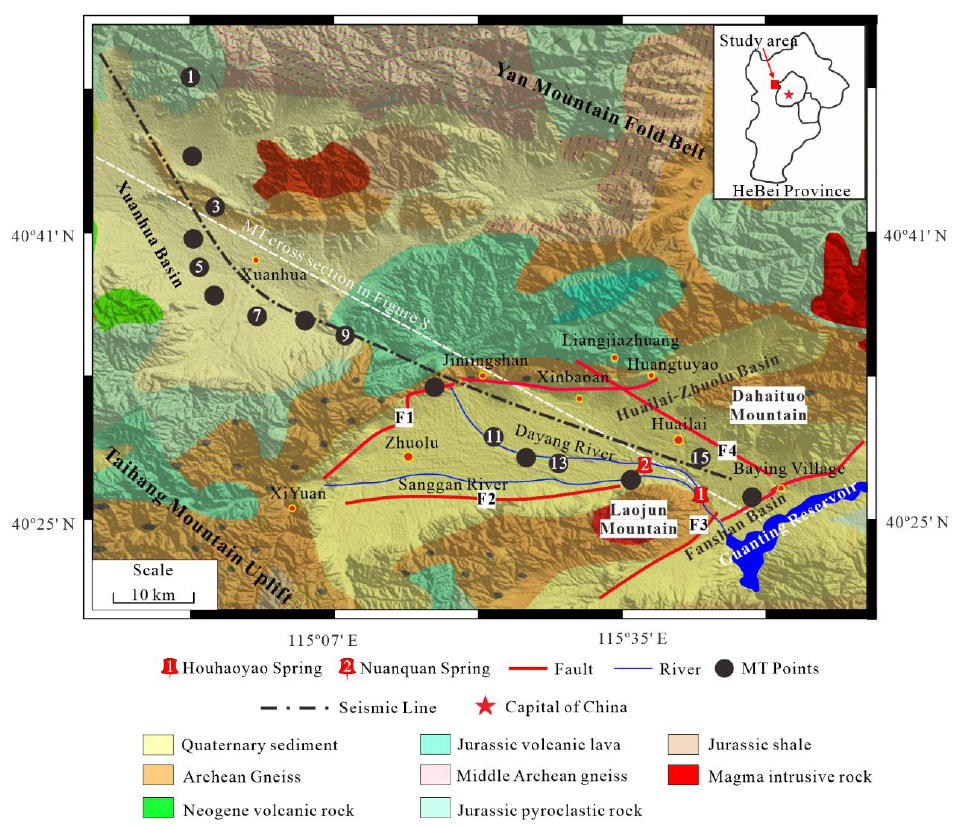
Figure 1. The geology and magnetotelluric sounding method (MT) site layout of the study area (the seismic line is modified from [29]).